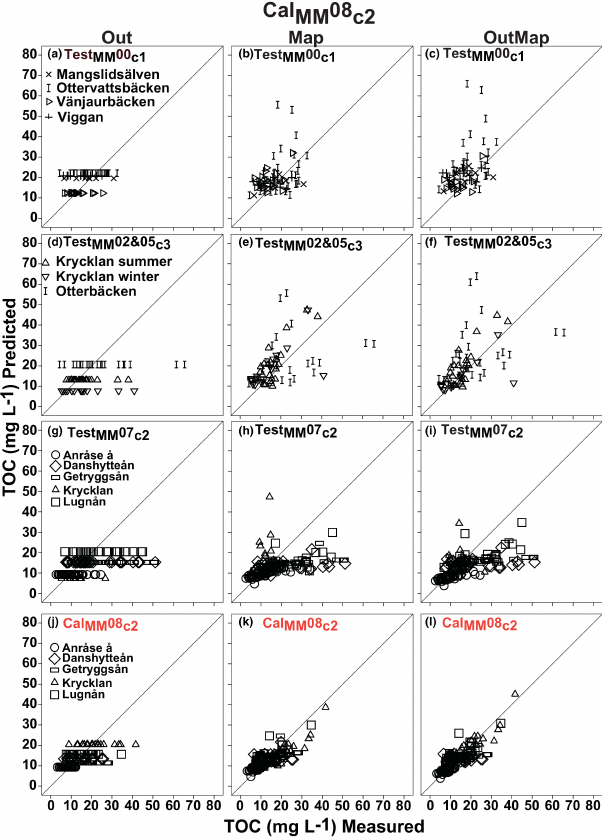
Figure 4. Scatterplots of measured headwaters with total organic carbon (TOC in mgL − 1 ) on the x axis, and the three different ver- sions of the mixed models Cal MM 07 c2 on the y axis: Out version on the left panel, OutMap version on the right panel and Map in- between. Data for year 2007 (Cal MM 07 c2 ) on the third row in red text, followed by Test data; first row 2000 data, second row 2002 & 2005 data and the last row is 2008 data. R. Anråse å indicated by circles, R. Danshytteån by diamonds, R. Getryggsån by rectangles, R. Krycklan by triangles (winter 2005 by upside-down triangles), R. Lugnån by squares, R. Mangslidsälven by multiplication sign, R. Ottervattsbäcken by upside-down triangles, R. Vänjaurbäcken by right tilted triangles and R. Viggan by plus sign. The black line is the 1:1 line.